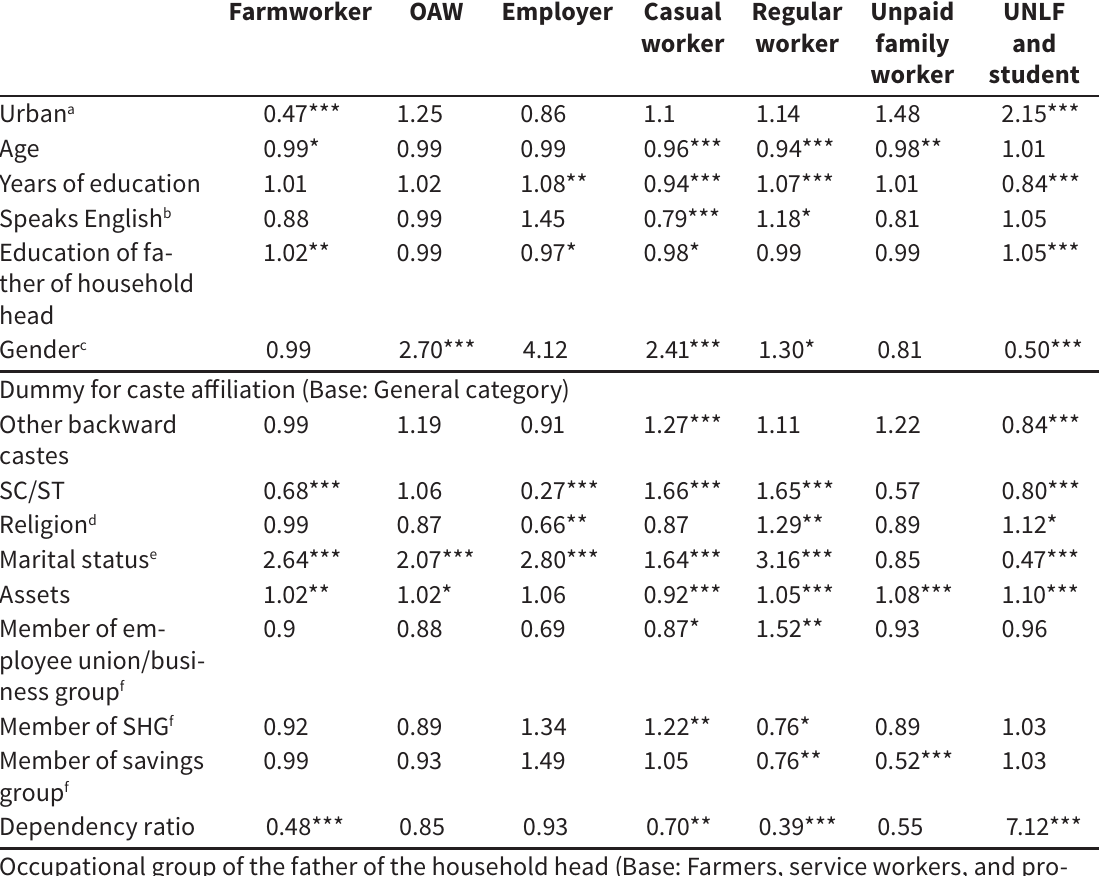
Persistence in labor market status and individual characteristics Farmworker OAW Employer Casual